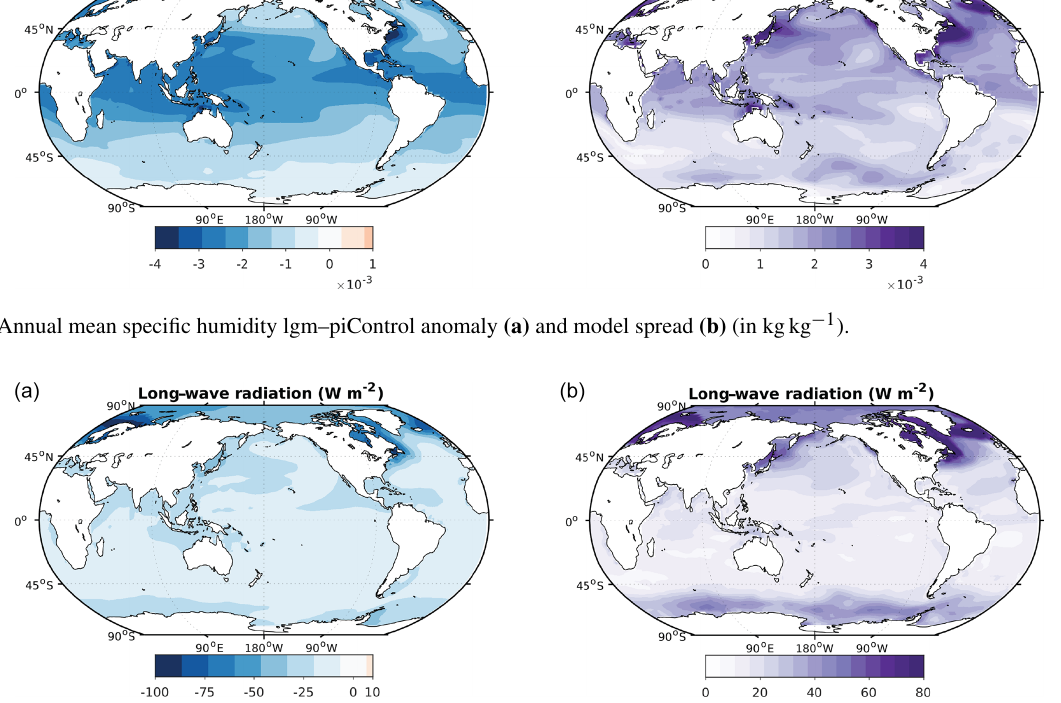
Figure 2. Annual mean downwelling long-wave radiation lgm–piControl anomaly (a) and model spread (b) (in Wm − 2